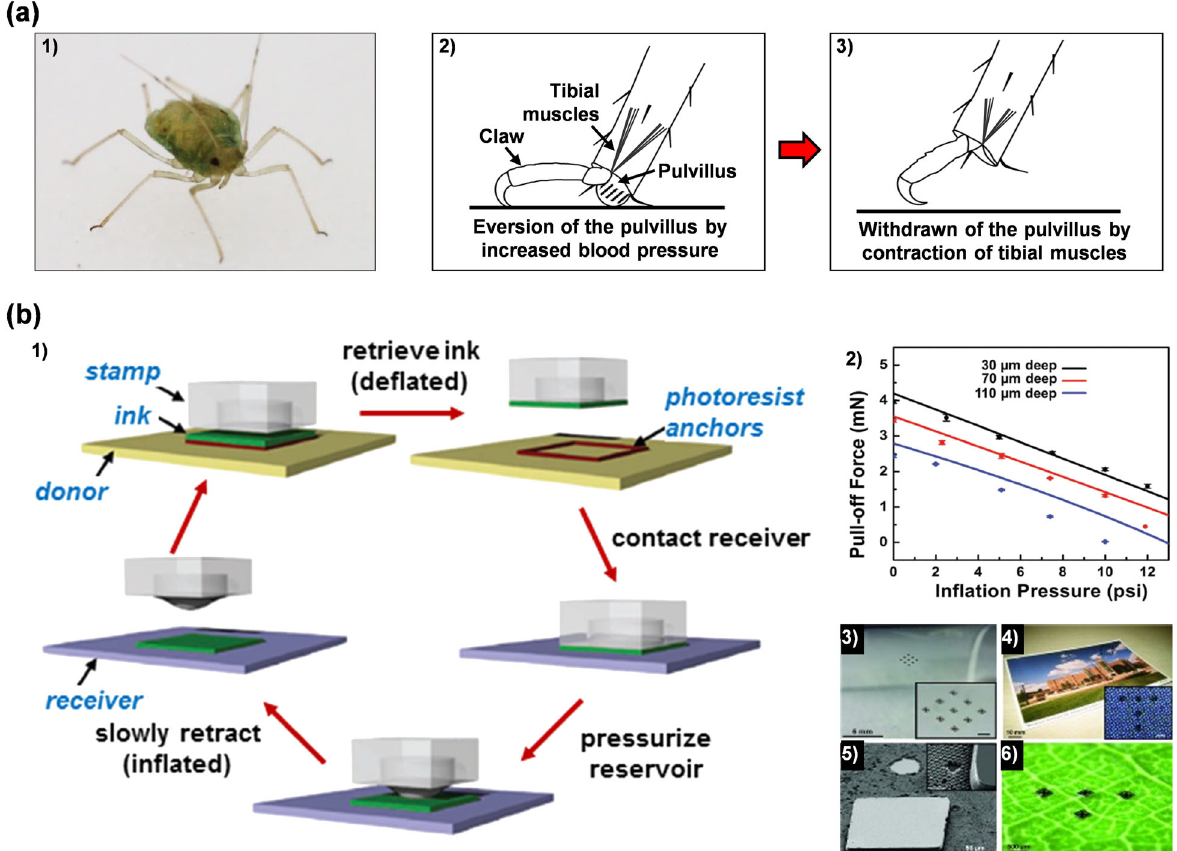
Fig. 7 Aphid-inspired transfer printing techniques: in fl atable stamp. a Image of an aphid and structure of the aphid adhesion system. (1) Optical image of an aphid clinging to a fl at surface; (2) Aphid adhesion organ (pulvillus) is everted to drive the mechanical sagging of the pulvillus and enlarge the contacting area, resulting in strong adhesion. (3) Aphid adhesion organ (pulvillus) is withdrawn by contraction of tibial muscles, which drives the retraction of the pulvillus and diminishes the contacting area, leading to weak adhesion. b Transfer printing technique using an in fl atable stamp: ( 1 ) Transfer printing process; ( 2 ) Experimentally and theoretically predicted decrease in stamp/silicon interfacial adhesion (maximum pull-off force) with the in fl ation pressure and ( 3 – 6 ) capacity demonstrations of transfer printing. Adapted with permission from ref.